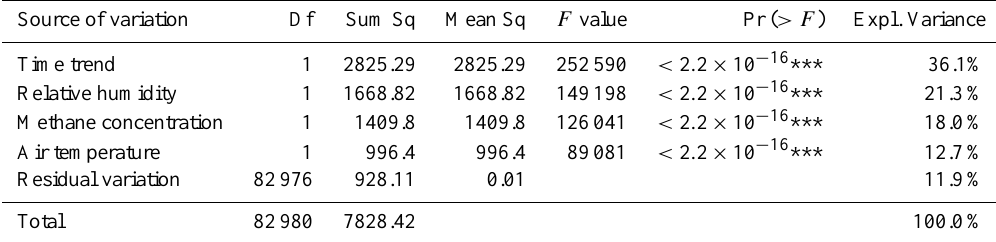
Table 1. Analysis of variance of the CH 4 sensor resistance R s /R 0 for Toolik Lake, summer 2011. Source of